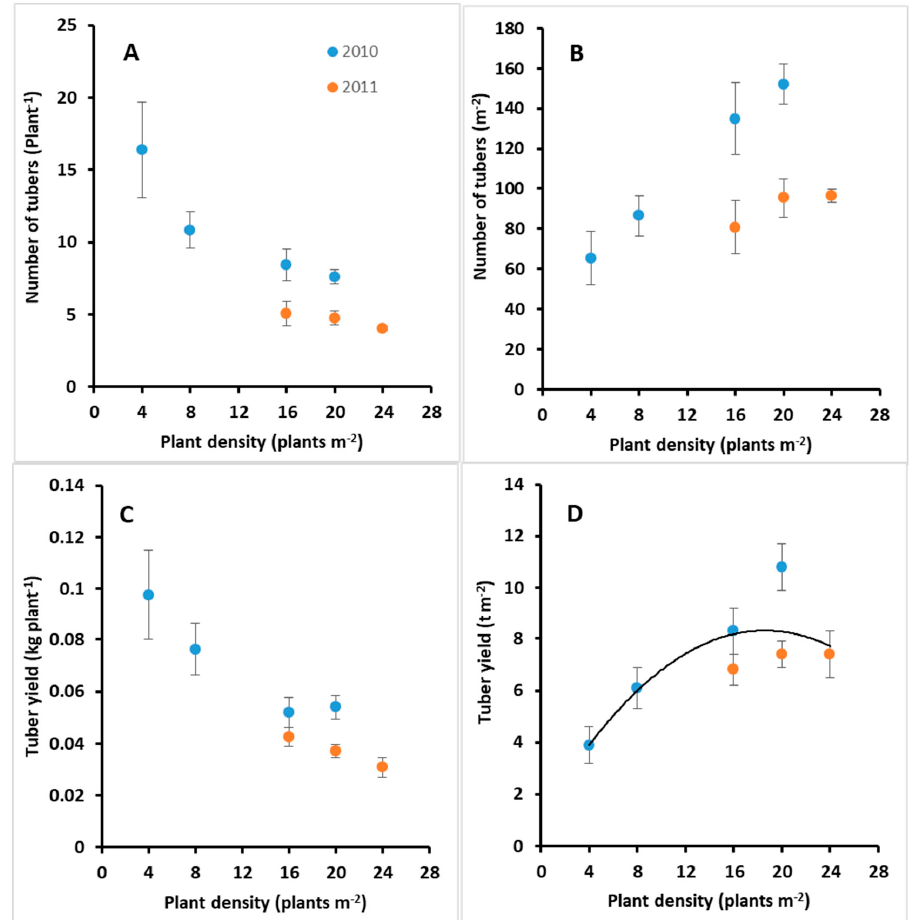
Figure 2. Effects of plant density on the number of HSB tubers per plant ( A ) and per area ( B ), and on the tuber yield per plant ( C ) and per area ( D ). The experiments were conducted in 2010 and 2011. Bars indicate SE. Agronomy 2021 , 11 , x FOR PEER REVIEW